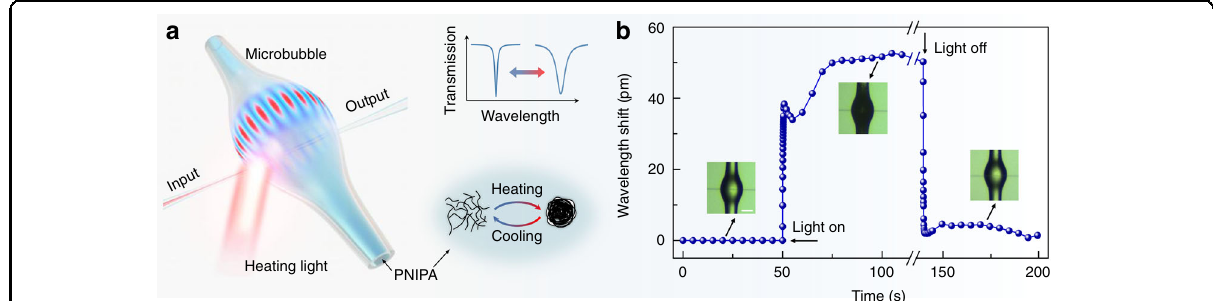
Fig. 1 Opto fl uidic microcavity for PNIPA sensing. a Schematic of microbubble sensors for in operando monitoring of phase transition dynamics. Inset: the variation of WGM spectra correlated to the mesoscopic structures of PNIPA, where the cyclic phase transition changing between hydrophilic state and hydrophobic state. b Time-resolved wavelength shift of a typical WGM sensor during one cycle of heating-light on and off. Inset: Optical microscope images of PNIPA-microbubble at different stages, in which the bright (dark) image indicates hydrophilic (hydrophobic) state. The scale bar is 40 μ